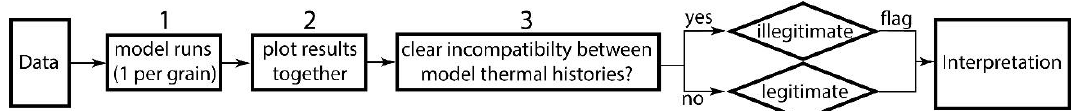
Figure 2. Flow chart of new method for evaluation and identifying illegitimate variation. Boxes labeled 1 – 3 represent the three steps outlined in the text.